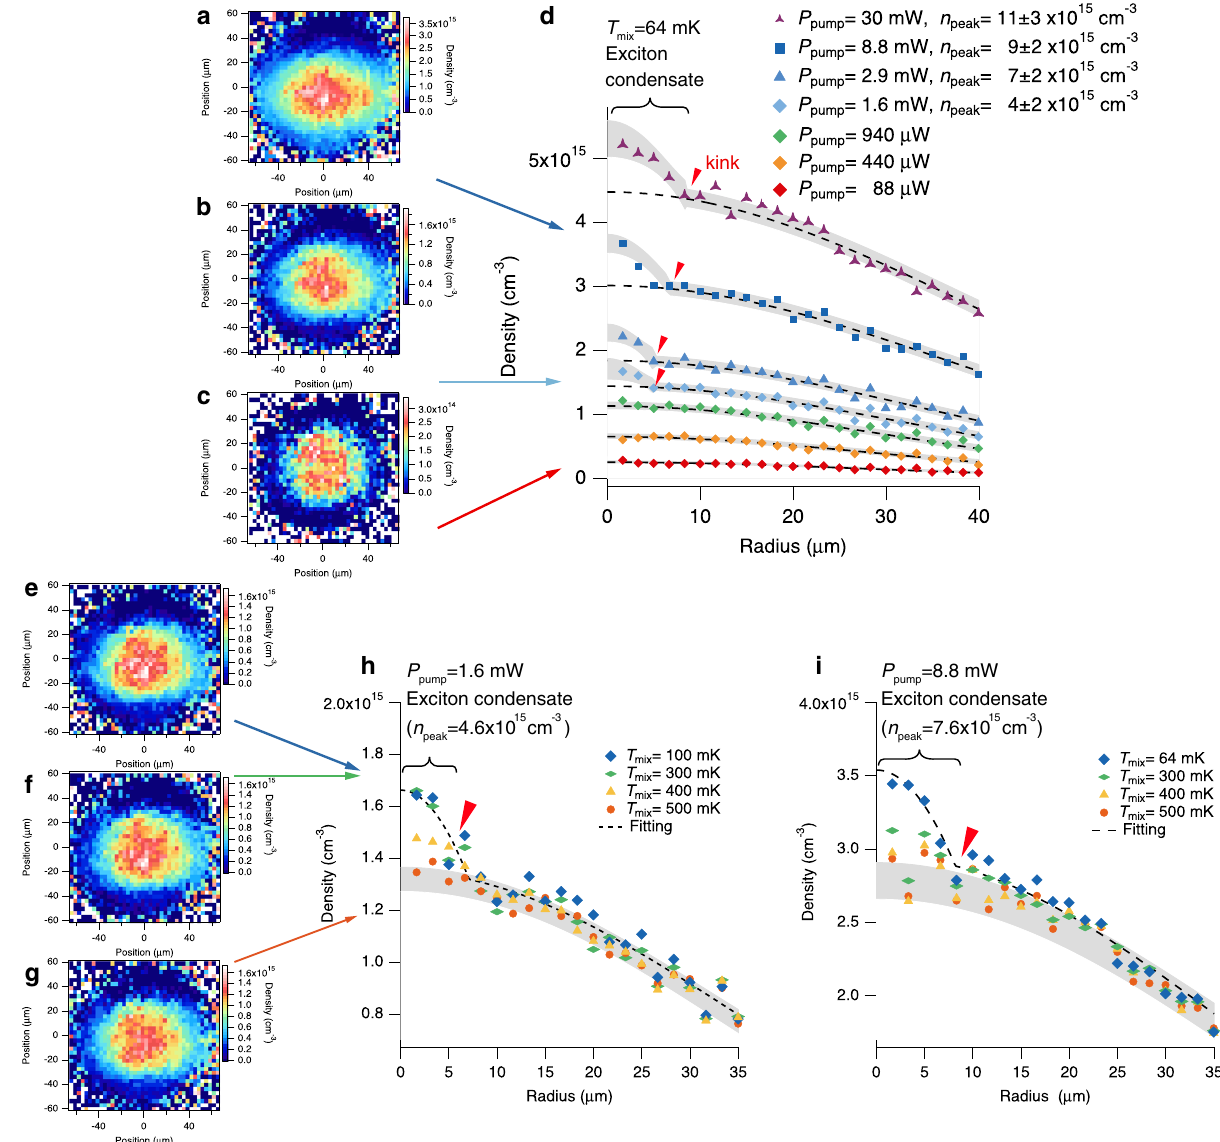
Fig. 4 | Paraexciton density measured by induced absorption imaging. a – c Spatial distributions of the paraexciton density for different excitation powers at T mix = 64 mK: a P pump = 8.8 mW, b P pump = 1.6 mW, and c P pump = 88 μ W. d Radial pro fi les of the averaged density (see Supplementary Note 5)at various excitation powersfor T mix = 64mK.The blackdashed curves show the Gaussian distribution fi t to the tail of the radial pro fi les. The grey shaded curves show the bimodal distribution fi t to the radial pro fi le of the density. The term n peak denotes the estimated peak density of trapped para- excitons. e – g Spatial distribution of the paraexciton density measured by